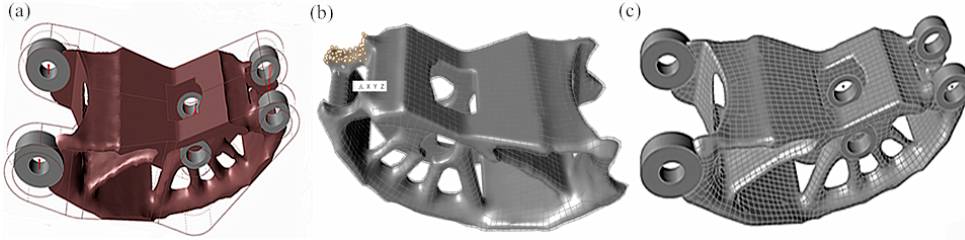
Figure 4. Automatic reconstruction: ( a ) Fitting effect; ( b ) Local adjustment; and ( c ) Reconstruction effect.